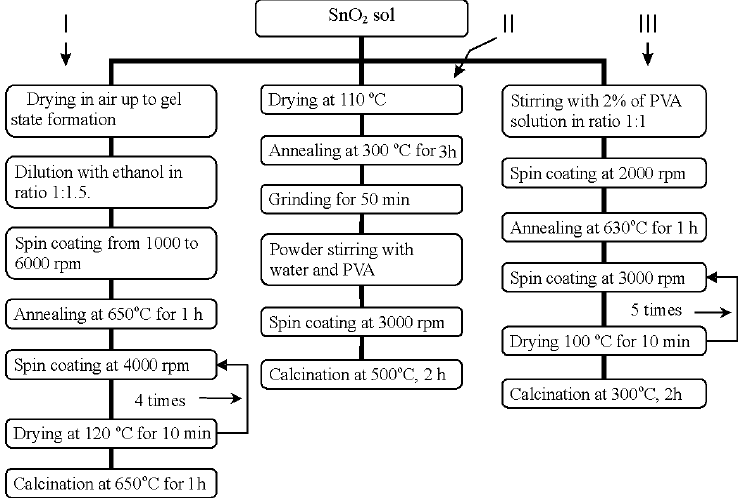
Figure 1. Flow chart for different modifications of SnO 2 thin films preparation by SnCl 4